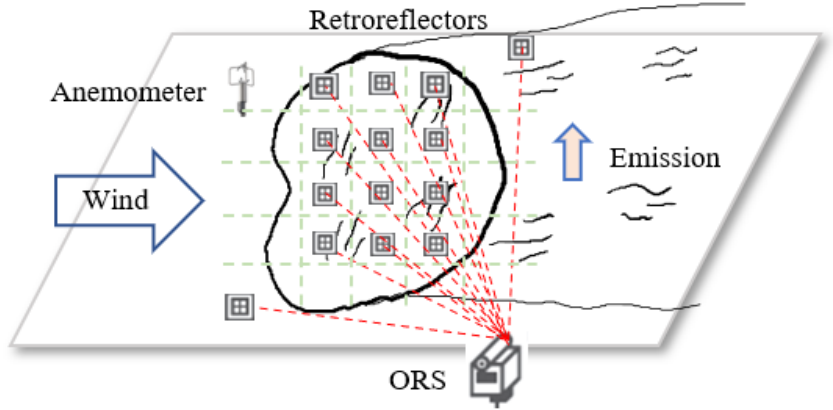
Figure 1. Schematic of the combined method of ORS ‐ CT and inverse ‐ dispersion techniques. (1) Data (1) Data collection